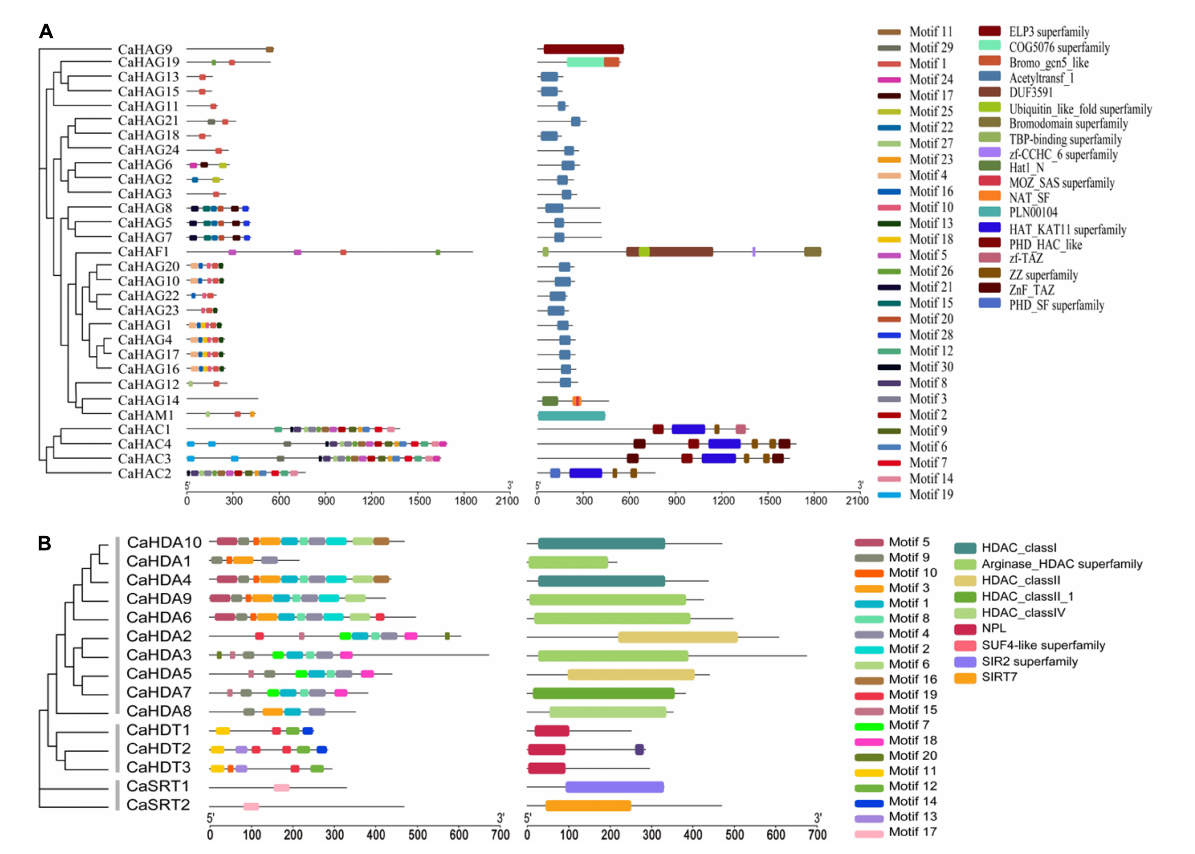
FIGURE1 Phylogenetic tree of CaHAT (A) and CaHDAC (B) proteins associated with the motif compositions and conserved domain. The maximum likelihood method was applied for the construction phylogenetic tree. The number at each node represents the bootstrap value from 5,000 replicates. The motif composition and conserved domain of each CaHAT and CaHDAC protein are exhibited in the middle of the figure. Motifs and domains are displayed on the right of the figure. The length of the protein can be estimated from the scale provided at the